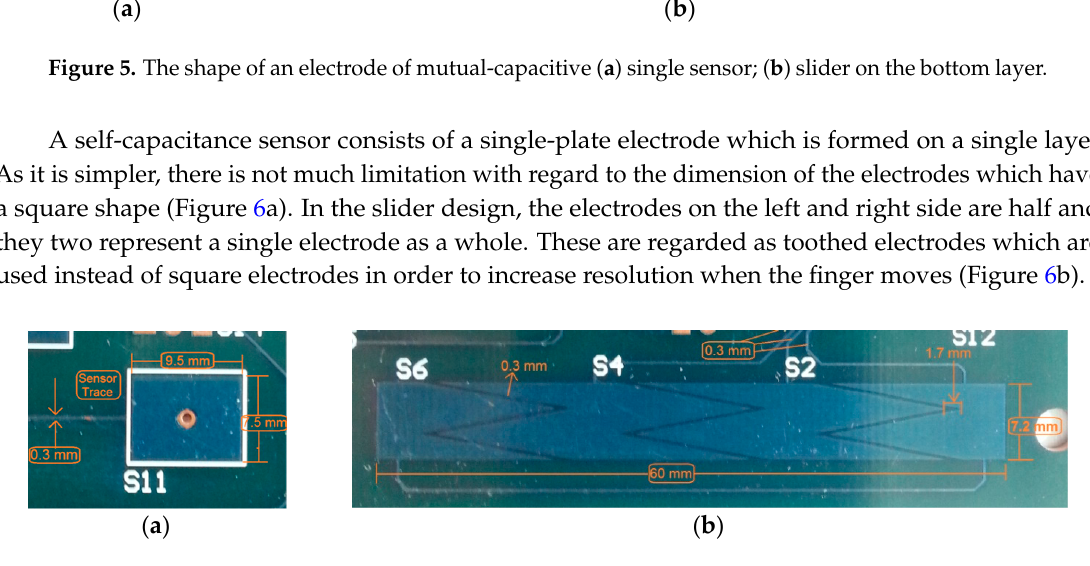
Figure 6. Construction of electrodes of self-capacitive ( a ) single sensor; ( b ) slider.